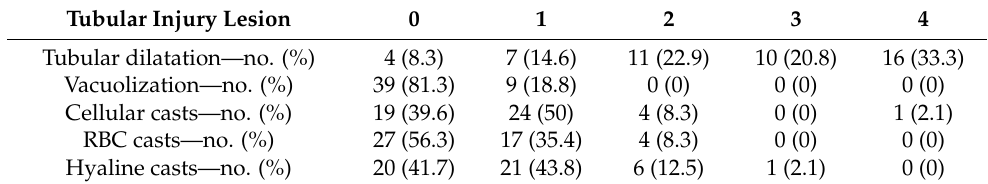
Figure 2. Tubular injury lesions in ANCA GN: Representative photomicrographs with tubular injury lesions are shown (scale bars: 100 μm). Abbreviations: ANCA, anti-neutrophil cytoplasmic antibodies; GN, glomerulonephritis; RBC, red blood cell. Table 2. Systematic scoring of tubular injury lesions in the total ANCA GN cohort.